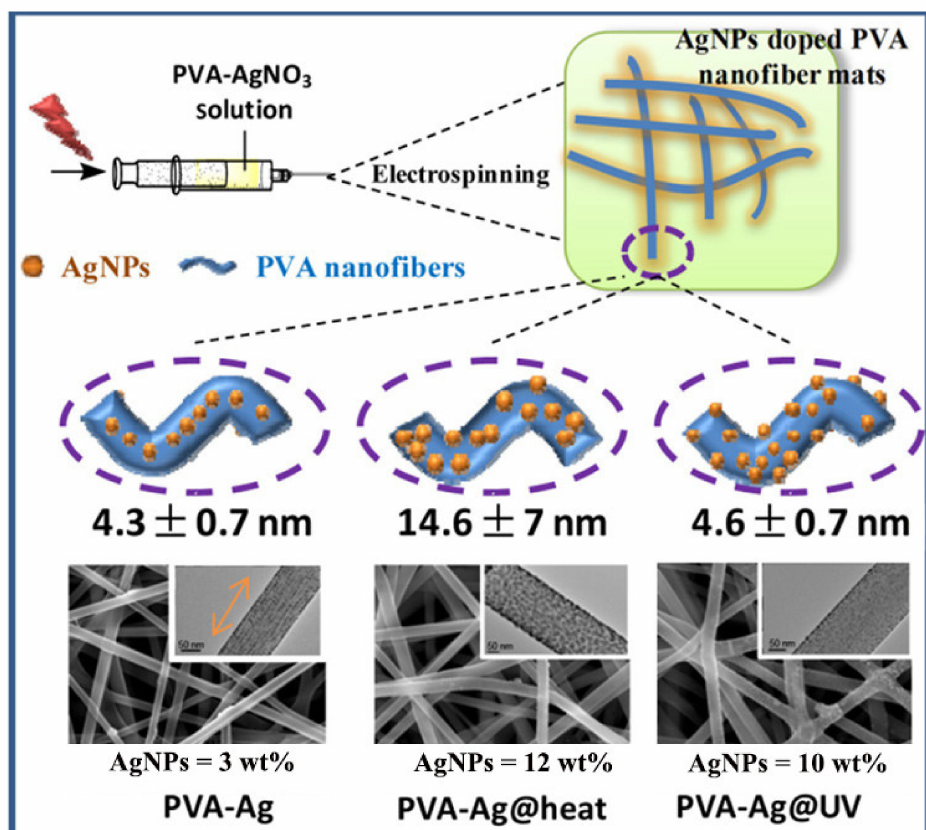
Figure 5. Overview of electrospinning process of Ag NP-doped PVA nanofiber mats under